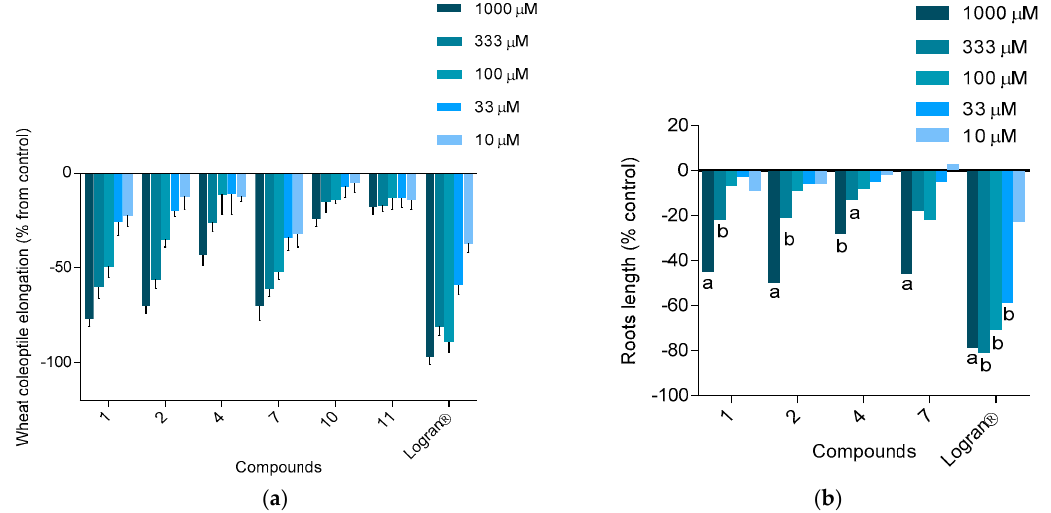
Figure 6. ( a ) Effects of compounds 1 , 2 , 4 , 7 , 10 and 11 on etiolated wheat coleoptile elongation. Values are expressed as percentage difference from the negative control. ( b ) Effects of compounds 1 , 2 , 4 and 7 on root growth of STS : Lycopersicum esculentum W. Values are expressed as percentage difference from the negative control and are not significantly different with P > 0.05 for Welch’s test. a Values significantly different with P < 0.01. b Values significantly different with 0.01 < P < 0.05.